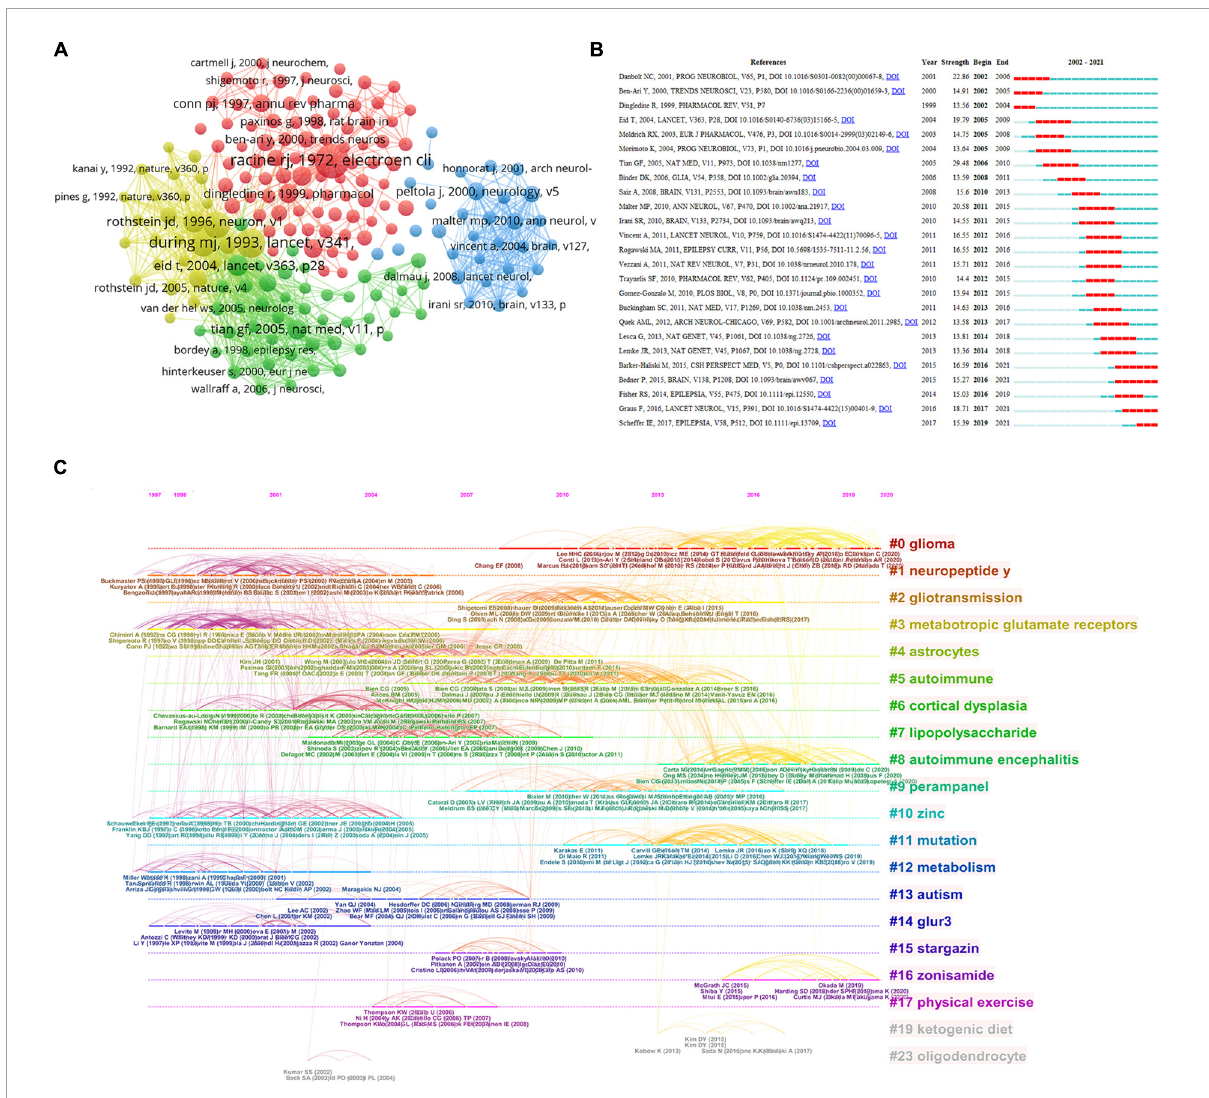
FIGURE7 Visualization of co-cited literature analysis. (A) Network of co-citations. (B) Representative burst citations in the top 25 papers with the most powerful citation burst. (C) Timeline distribution of